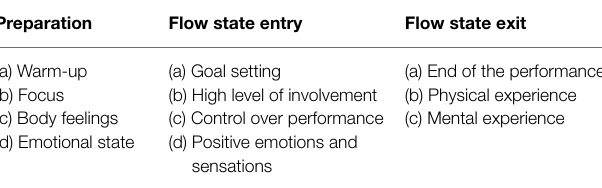
TABLE 1 | The three phases and their